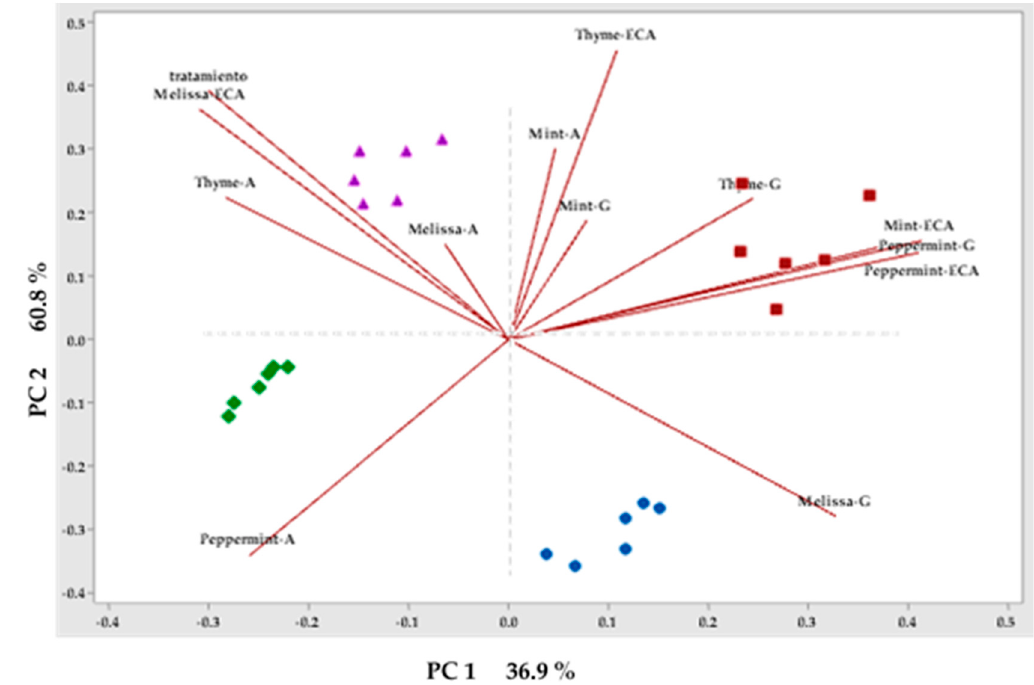
Figure 3. Principal component analysis (PCA) c) Biological activity ( α -amylase, α -glucoside and ACE) by drying method and plant materials [the different drying methods correspond to the Blue (Fresh plant), red (Microwave oven), green (Conventional) and violet (Freeze drying) icons] and [Acronyms per sample indicate A ( α -amylase), G ( α -glucosidase), and ECA (Angiotensin converting enzyme)] [Red line indicates the direction of the maximum variance of the data to orthogonal axes of each component.].